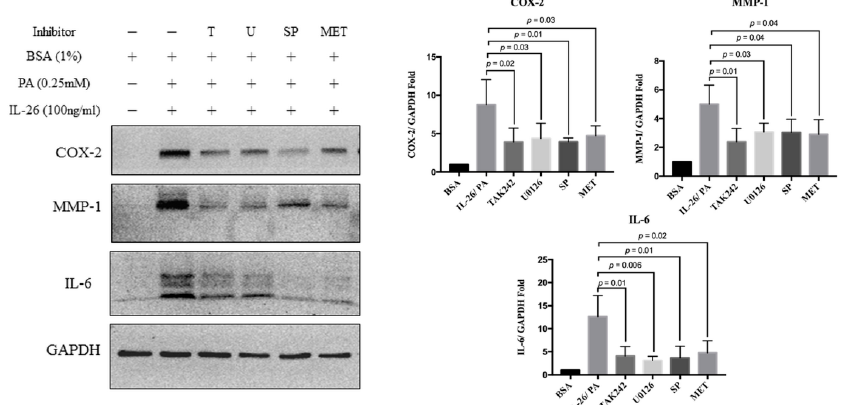
Figure 4 . Effects of specific signaling inhibitors and metformin on HACs treated with palmitate and IL-26. COX-2, MMP- 1, and IL-6 protein levels in HACs treated with palmitate (0.25 mM), IL-26 (100 ng/mL), TAK242 (10 μ M), U0126 (10 μ M), SP600125 (25 μ M), or metformin (5 mM) for 24 h, as determined by Western blot analysis. Data are presented as the mean ± SD. Significant differences were detected between the IL-26 + palmitate and inhibitor or metformin groups ( n = 3).